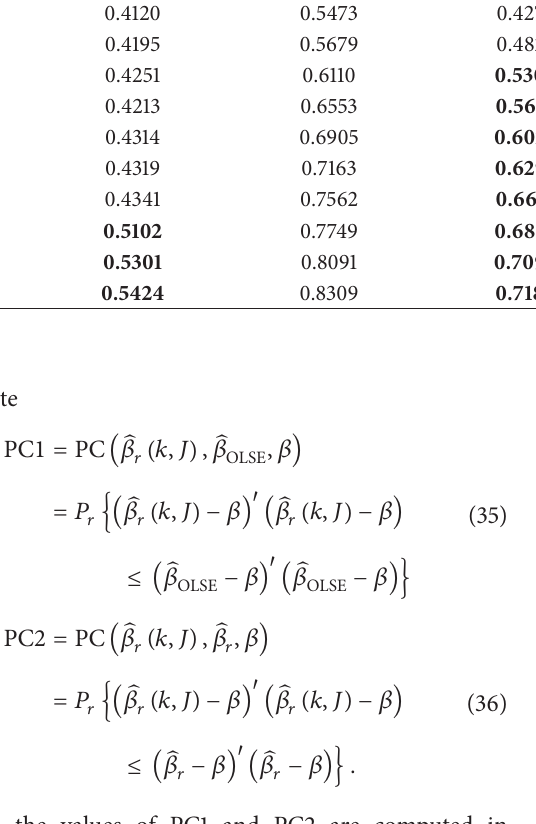
Figure 1: The PC of 𝑚𝑟 - 𝑘 class estimator relative to